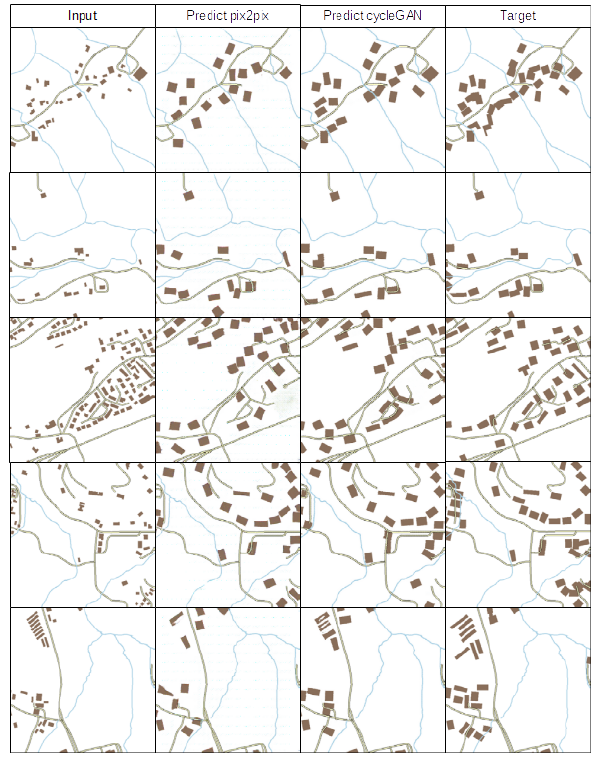
Figure 2. Examples of results from pix2pix and CycleGAN to reproduce an agent-based